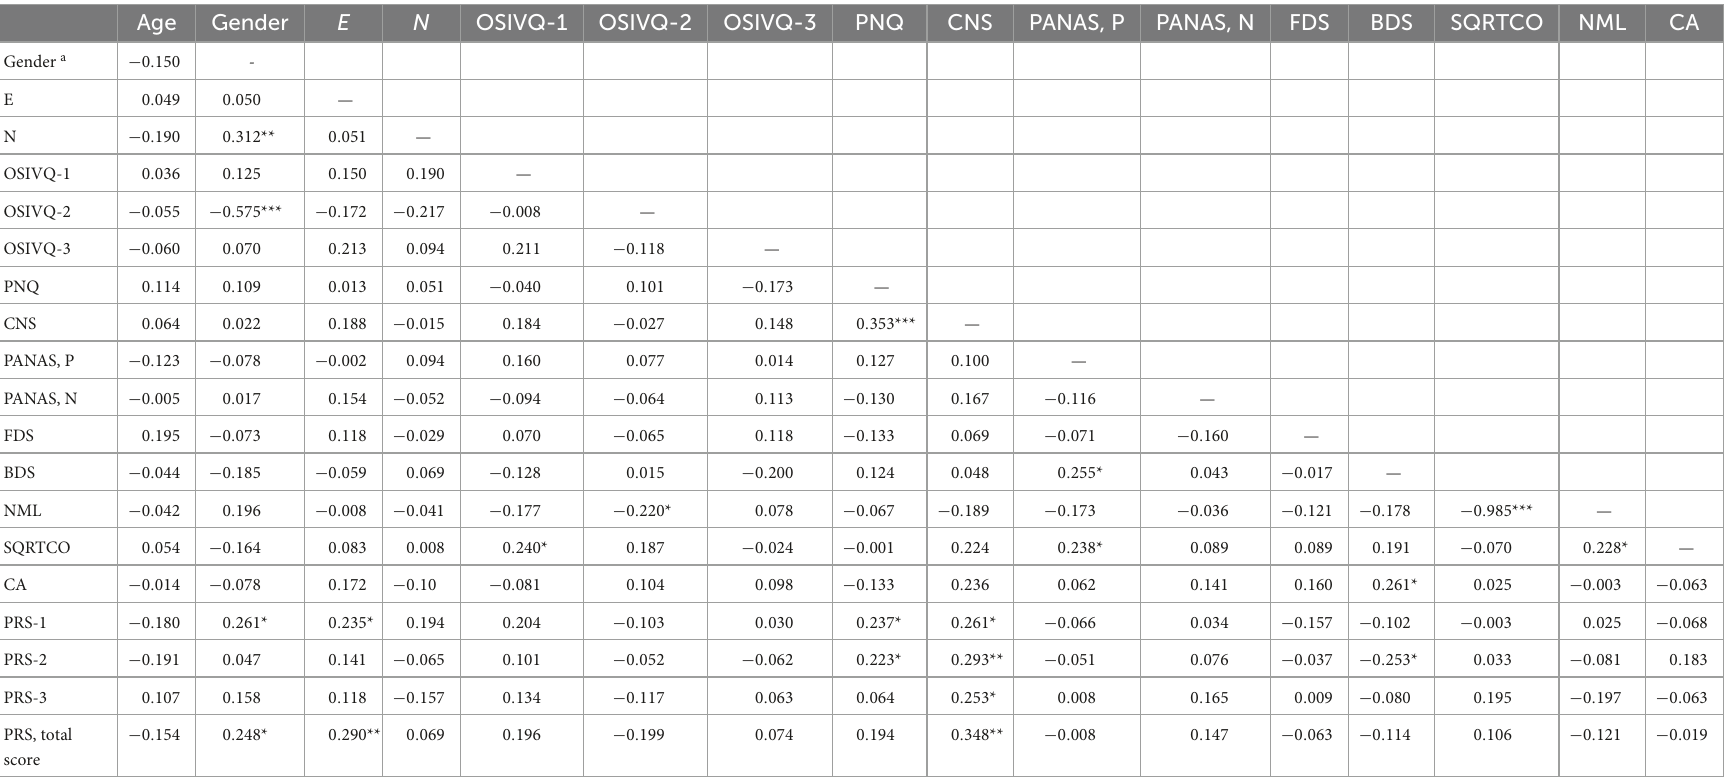
TABLE 1 Correlations between measures of